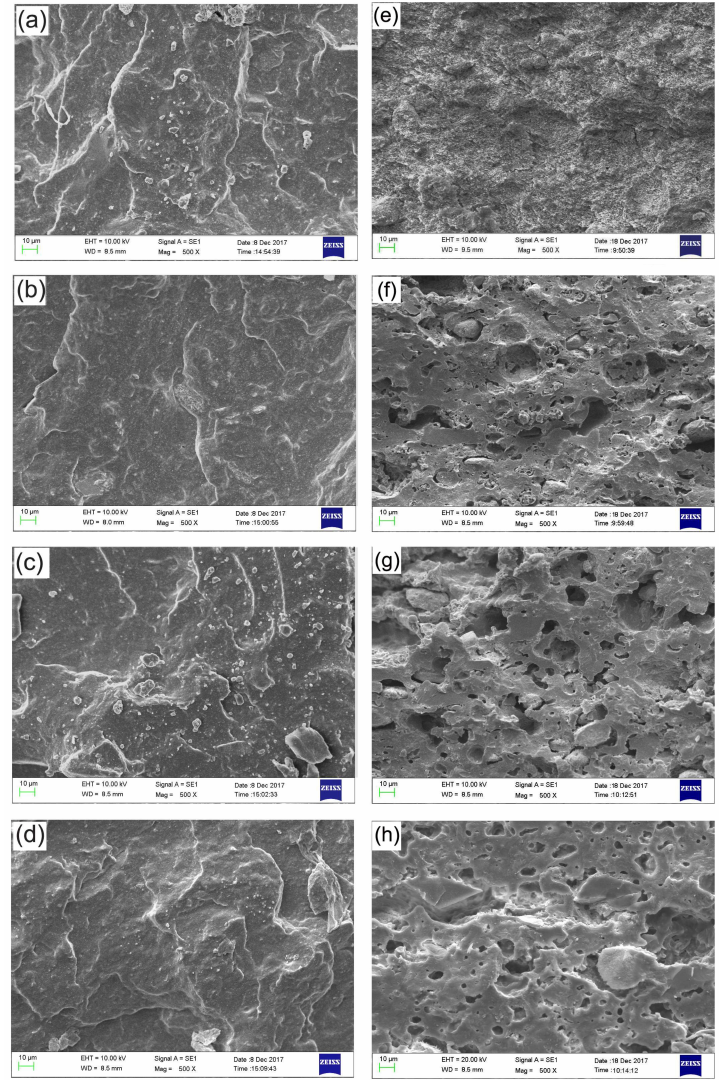
Figure 8. Morphology of tensile fracture surfaces of ( a ) the control and ceramizable, ( b ) NaB, ( c ) NHB, and ( d ) ZB composites and impact fracture surfaces of ( e ) the ceramic residue obtained from the control composite and the ceramic ones derived from the decomposition of the ( f ) NaB, ( g ) NHB, and ( h ) ZB composites,